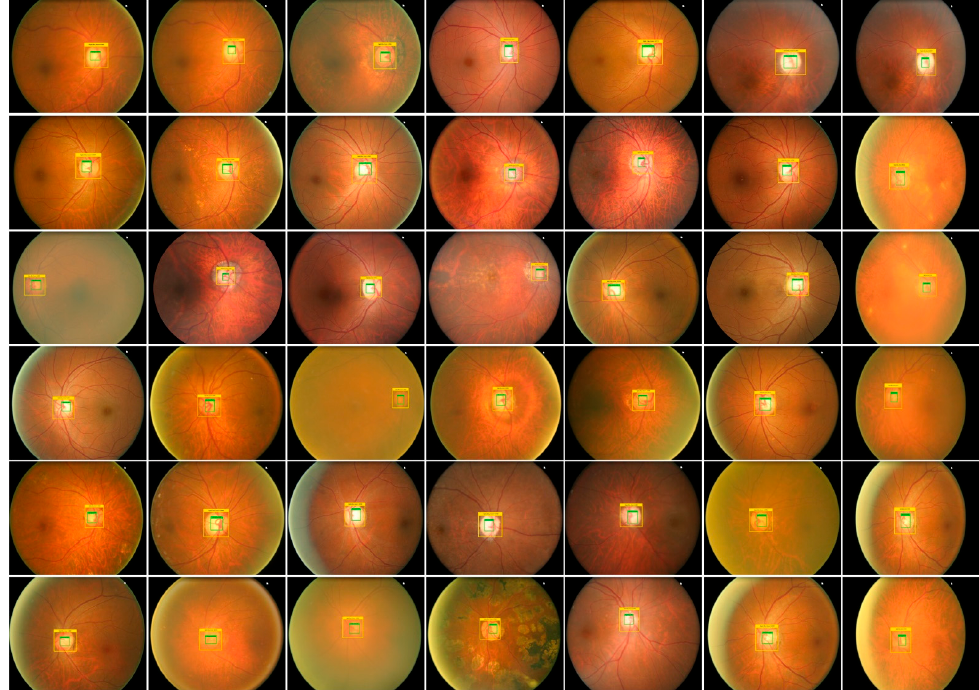
Figure 6. Localization results of EfficientDet-D0 for glaucoma localization.